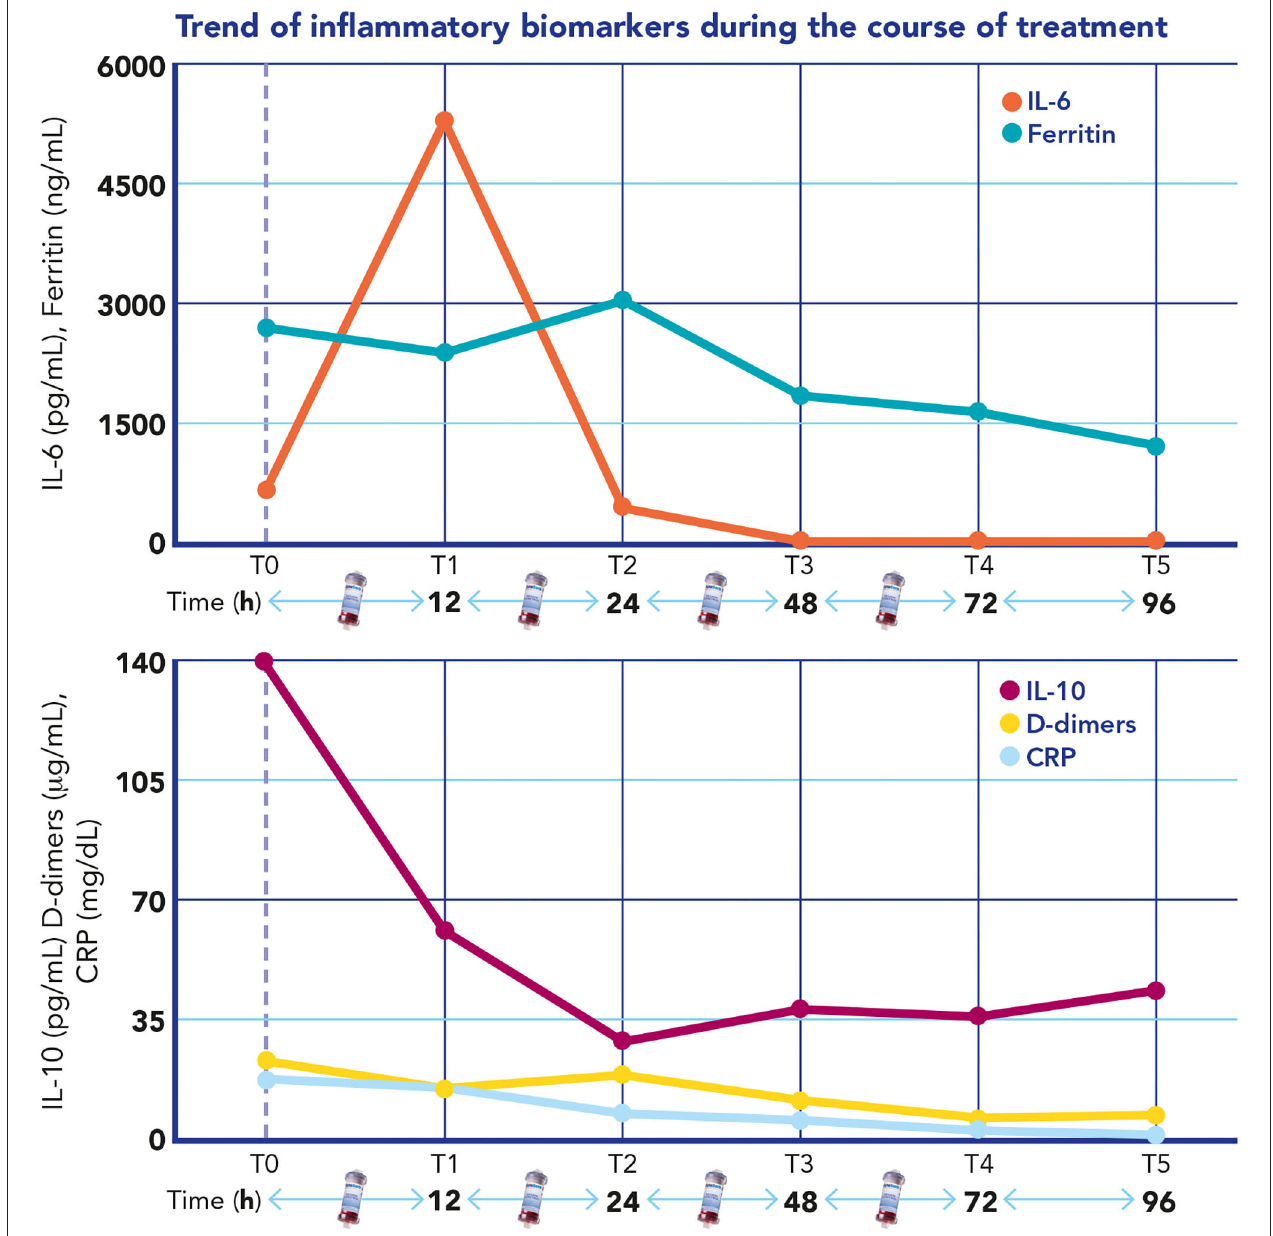
FIGURE 2 | Time course of interleukin 6, interleukin 10, C-reactive protein (CRP), D-dimers, and ferritin during extracorporeal blood purification treatment.